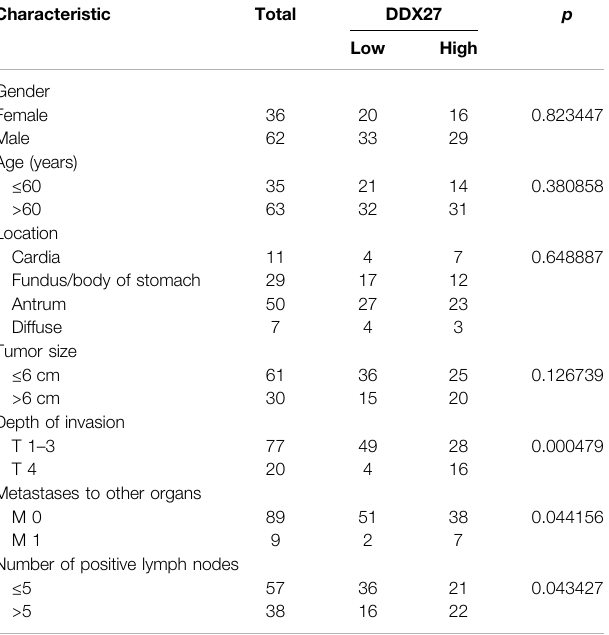
PS: bold fonts represent p < 0.05.